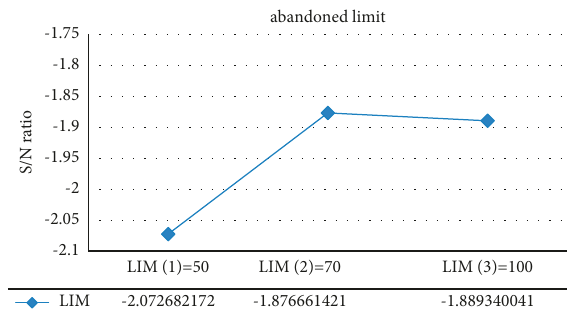
Figure 3: Graph of the average S / N ratio for each level of the ABC algorithm lim factor in model solution.